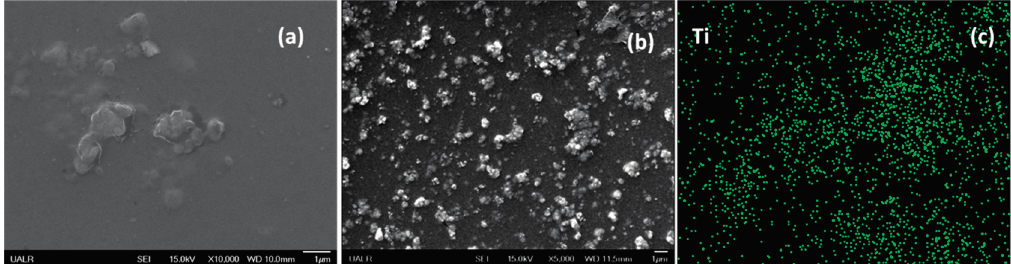
Figure 5. SEM images of ( a ) TANIPANI thin film; ( b ) TANIPANI-TiO 2 thin film; and ( c ) EDS image showing the dispersion of Titanium in TANIPANI-TiO 2 thin film.